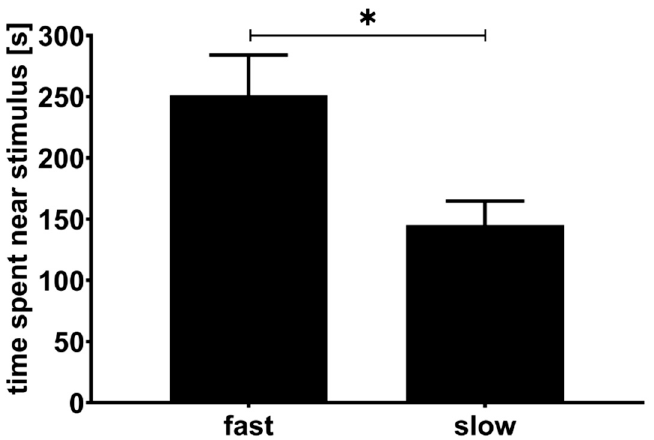
Figure 4. Results of dichotomous mate choice tests to assess directional mating preferences of male guppies for female swimming activity. The mean ( ± SE) times males spent near fast (2.7 cm/s) and slow (0.7 cm/s) moving female animations are shown. An asterisk indicates significant difference ( p < 0.05) in paired ‐ samples t ‐ test.